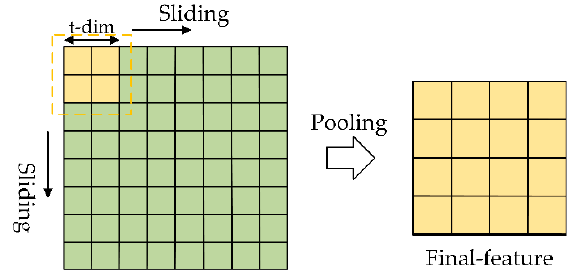
Figure 3. Pooling to obtain final feature vectors.